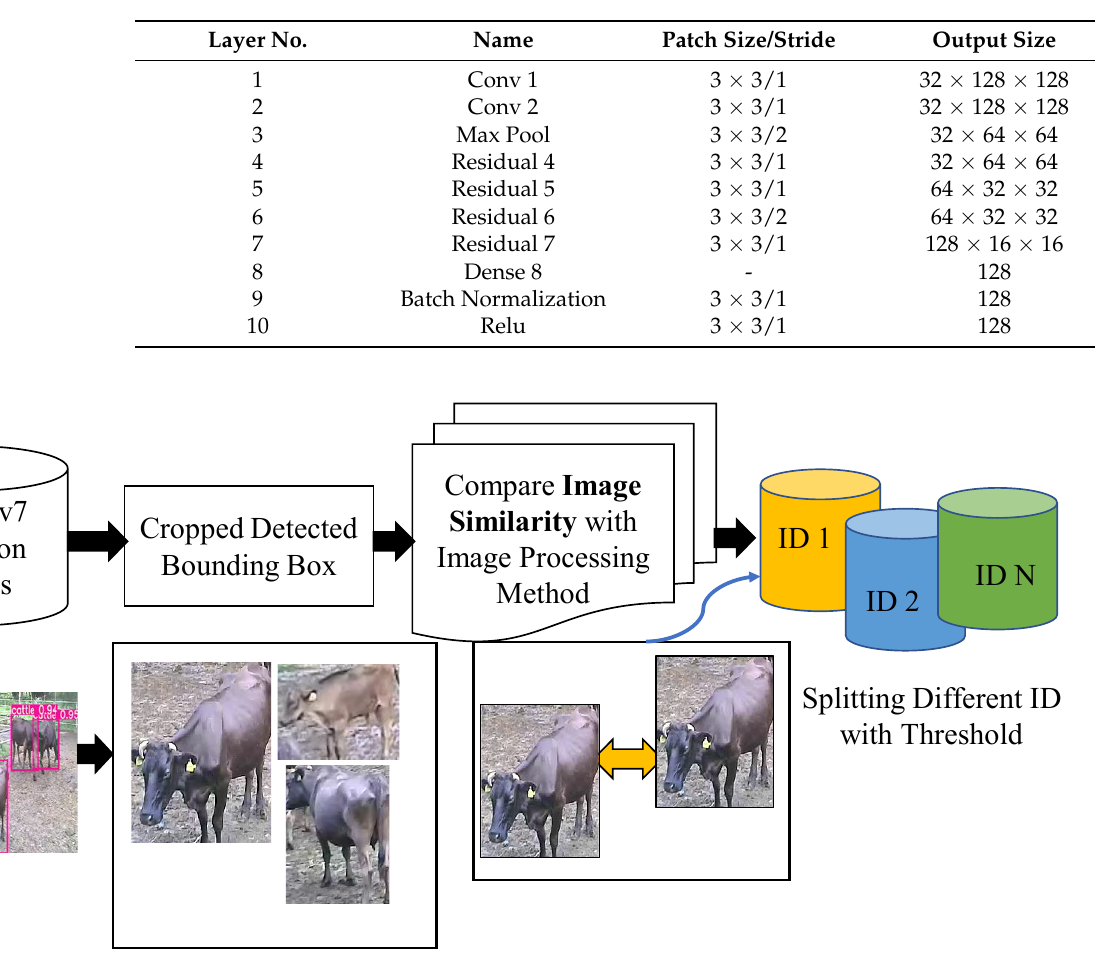
Figure 7. Building the cattle re-identification dataset with the thresholding method .